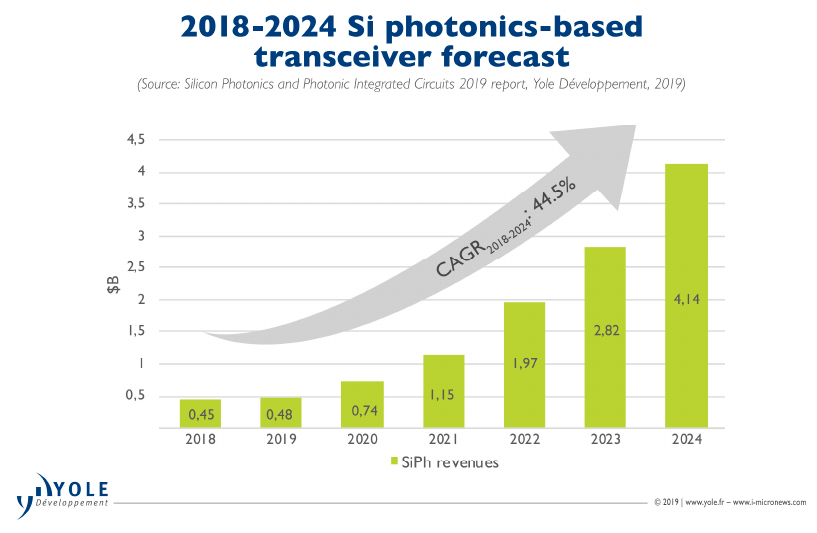
Figure 1. Silicon photonics 2013–2025 market forecast [1]. Reproduced with permission from S. Leroy, Director, Public Relations at Yole Développement.